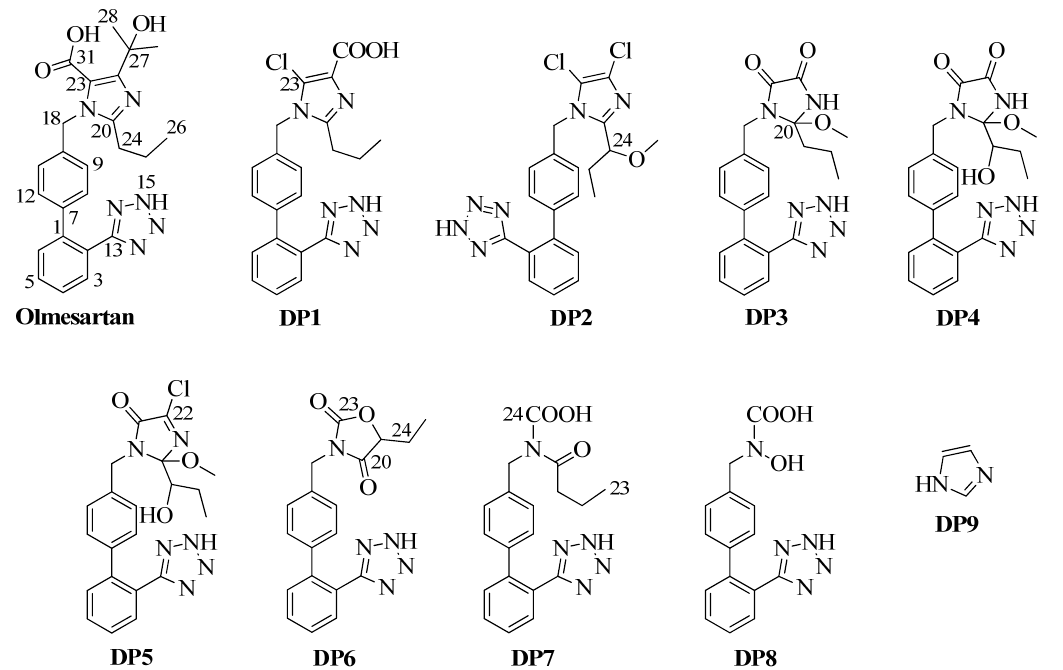
Figure 1. Chemical structures of olmesartan acid and its degradation byproducts DP1–DP9.